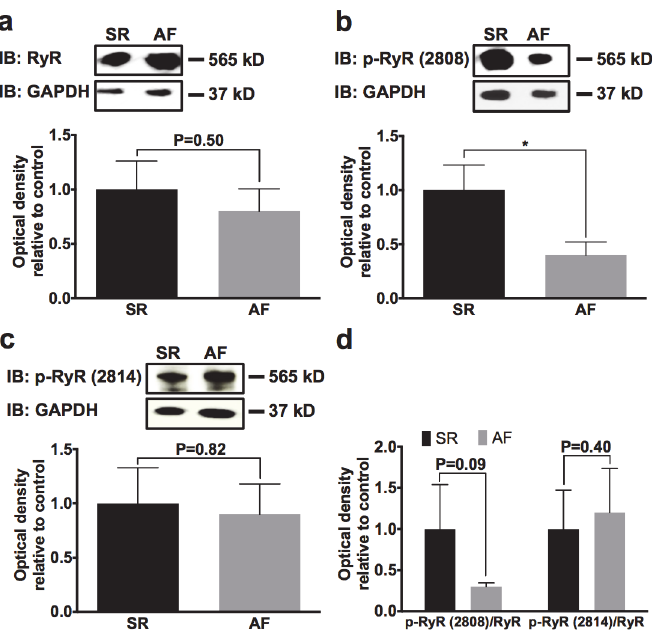
Fig 5. Analysis of ryanodine receptor (RyR) and phosphorylated ryanodine receptor (p-RyR) levels in SR and AF pigs. a Total RyR protein did not differ between animal groups. b, c PKA-phosphorylated RyR at Ser2808 was reduced, while CaMKII-phosphorylated RyR at Ser2814 was not affected by AF. d Relative p- RyR Ser2808 but not p-RyR Ser2814 content was diminished in atrial tissue obtained from n = 5 animals per group. Original Western blots and mean normalized optical density data are provided ( * P < 0.05).